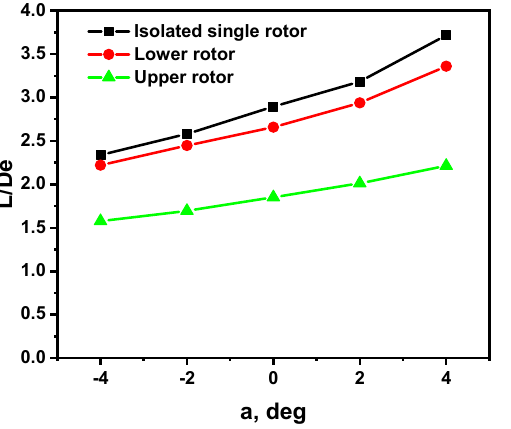
Figure 20. Variations of L/De ratio with rotor shaft tilt angles (a) for coaxial and isolated single rotors.